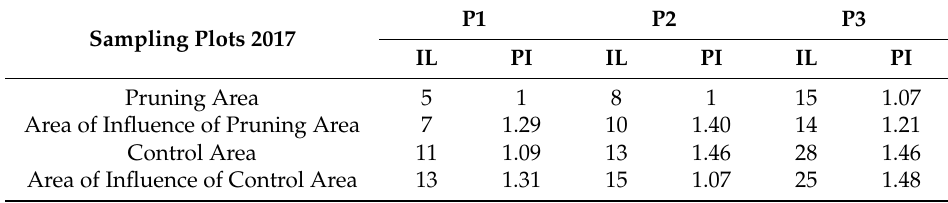
Table 5. Values of Infestation Level (IL) in %, and Population Intensity (PI) in average number of dry branches/tree, corresponding to each sampling area established inside each sampling plot (P1, P2, and P3) in